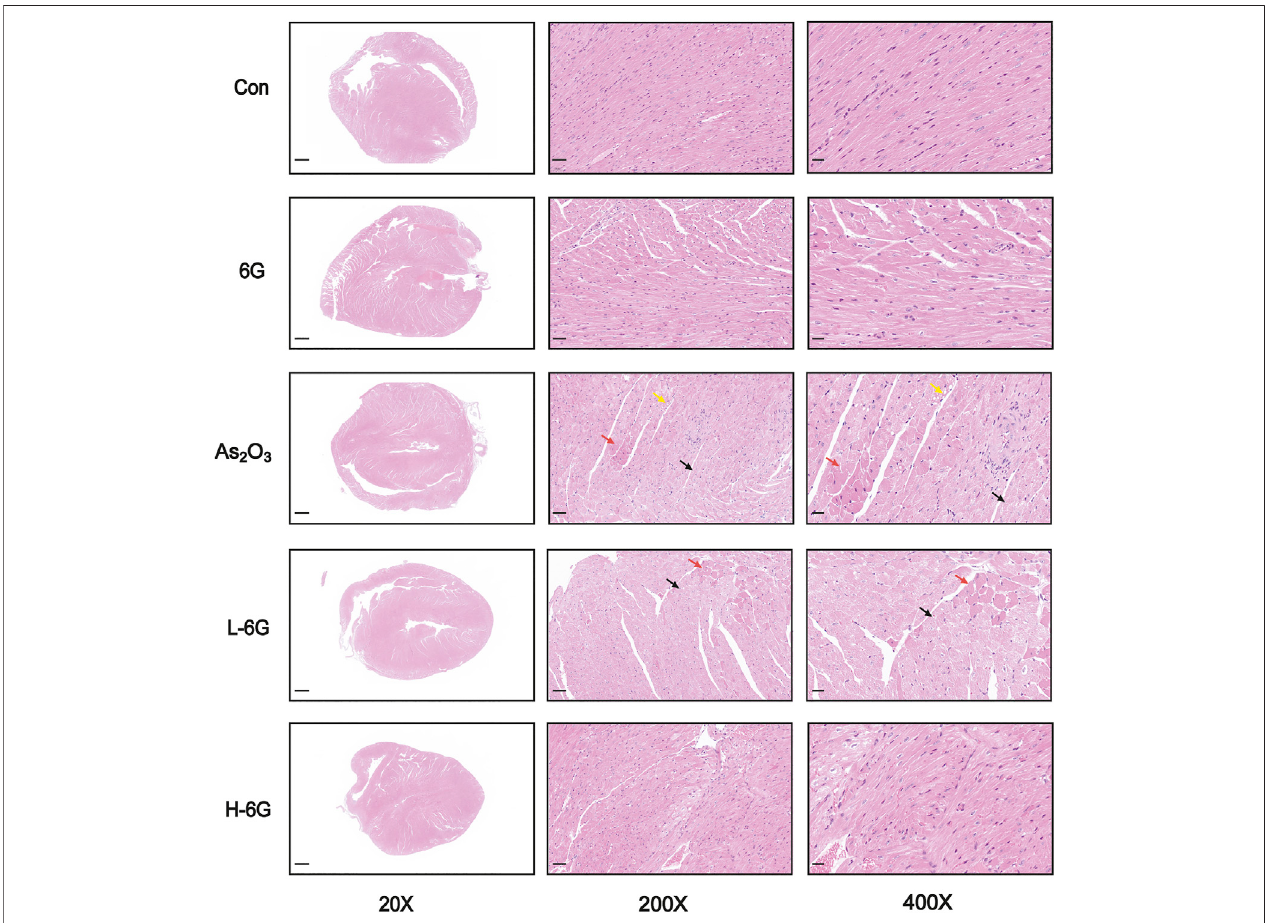
FIGURE 5 | Histological examination in each group. Red arrows represent cell necrosis, yellow arrows represent edema, and black arrows represent muscle fi ber loss. n = 6.